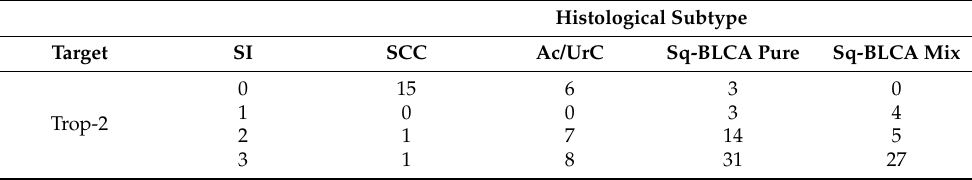
Table 5. Immunohistochemical results of Trop-2 expression in histological subtypes of bladder cancer.